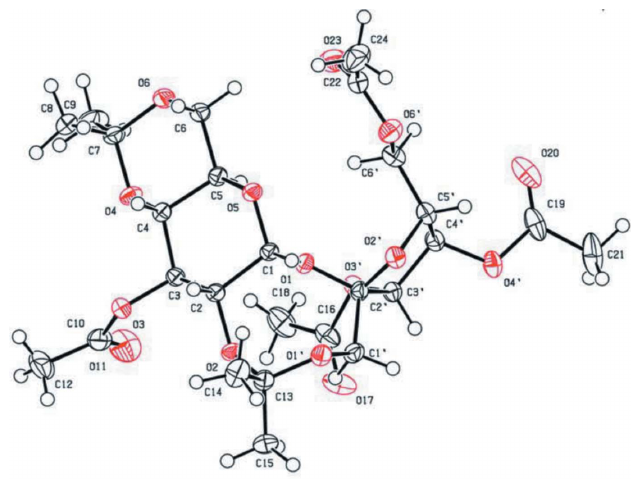
Figure 1 The molecular structure of the title compound with atom labelling [same as employed by Drew et al. (1979)]. Displacement ellipsoids are drawn at the 50% probability